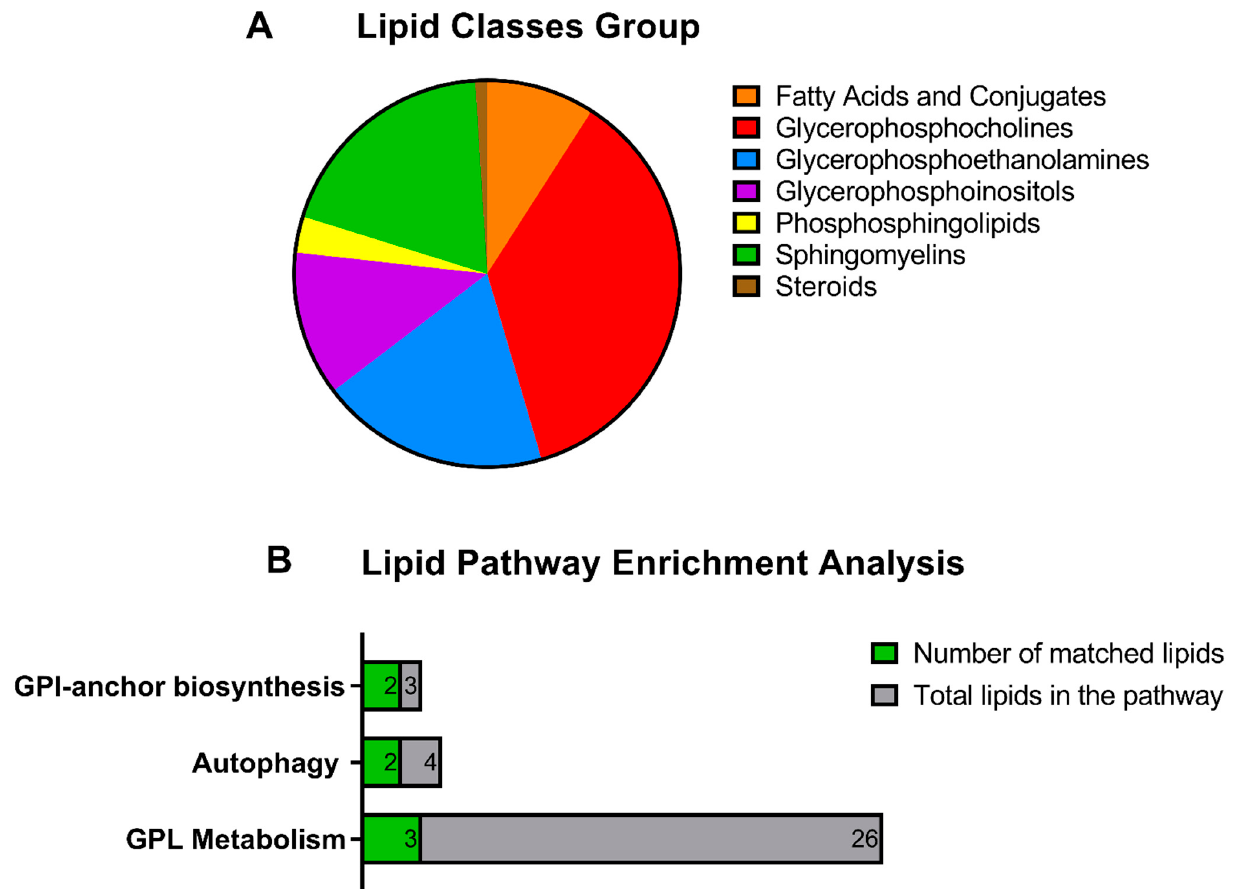
Figure 4. Lipid pathway enrichment analysis of plasma samples showing ( A ) the lipid classes that were detected in plasma regardless of the groups and ( B ) the lipids changing in the MCI and AD samples, representing the most impacted pathways. The green bars show the number of lipids that were measured in our sample and belonged to these pathways. Abbreviations: GPI, glycosylphosphatidylinositol; GPL, glycerophospholipid.